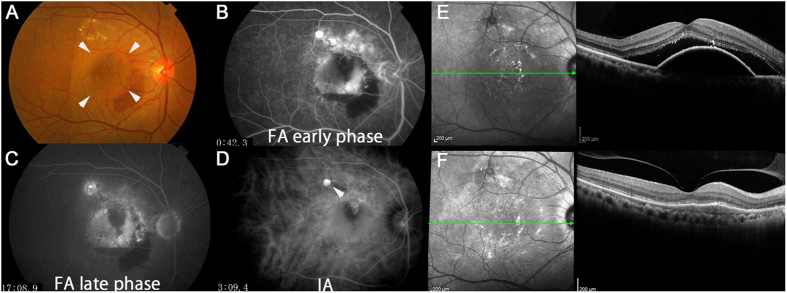
A representative case with serous pigment epithelial detachment (PED) and subretinal fluid (SRF) successfully treated with intravitreal aflibercept (IVA) in the treatment-naive group.This was a 63-year-old man with treatment-naive polypoidal choroidal vasculopathy and best-corrected visual acuity (BCVA) of 1.0 in decimal (logMAR 0) at baseline. Arrowheads in the fundus color photograph (A) indicate serous PED. Fluorescein (B,C, early phase and late phase respectively) and indocyanine green (D) angiograms. The arrowhead indicates a polyp lesion. An optical coherence tomography image (E) showed that at month 12, serous PED and SRF at baseline had disappeared after 7 IVA treatments.